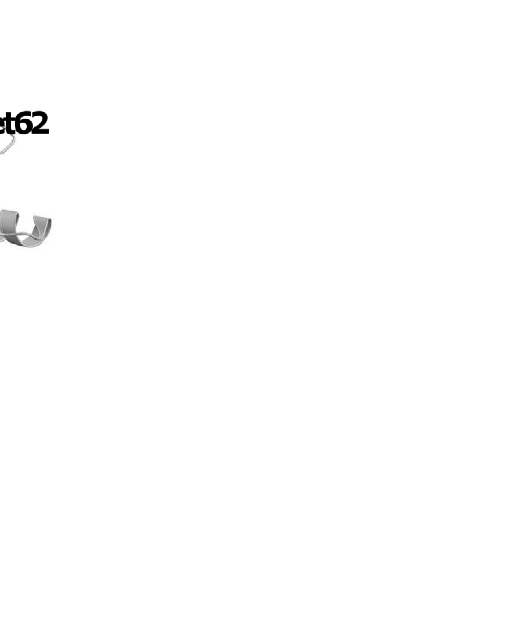
PLoS Computational Biology |